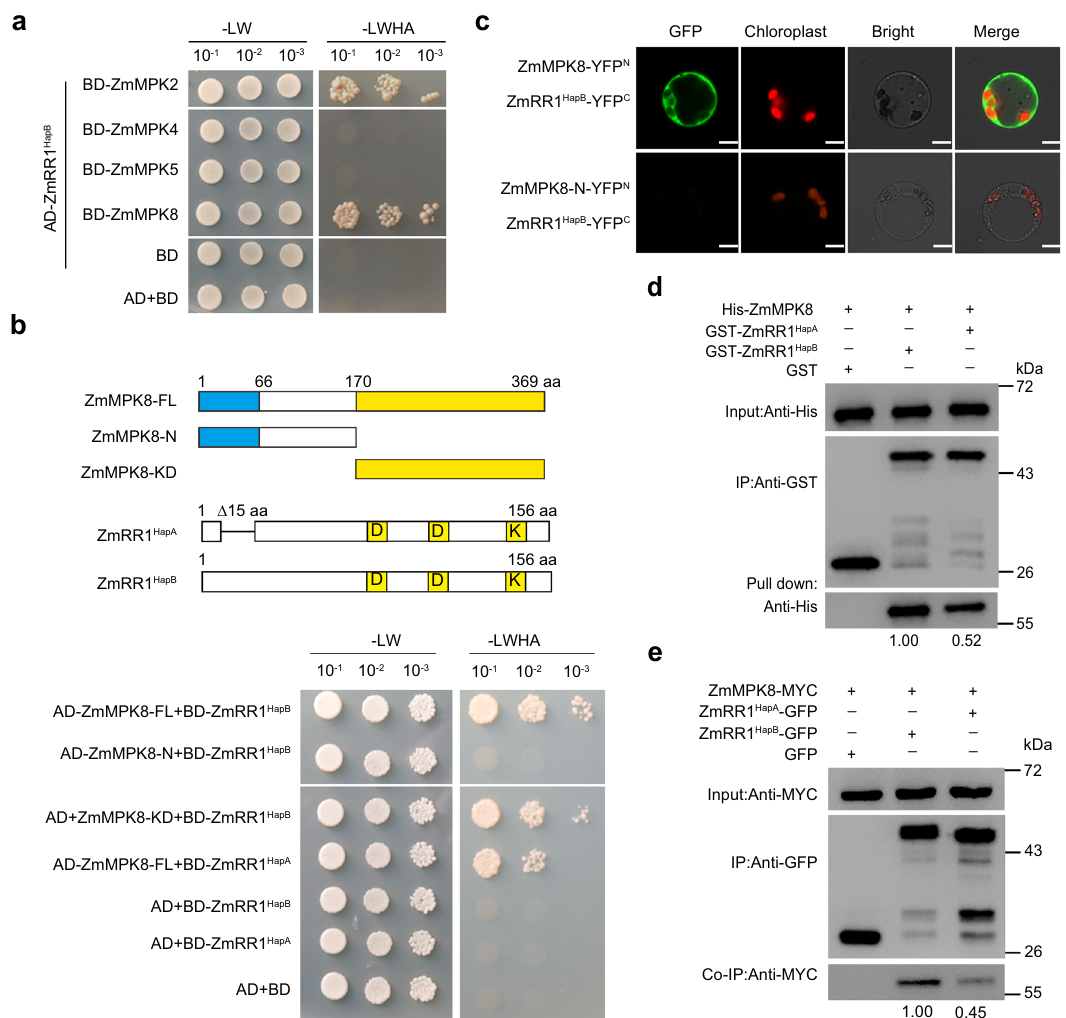
Fig. 2 ZmMPK8 interacts with ZmRR1 in vitro and in vivo. a Interactions of ZmMPKs with ZmRR1 in yeast. Yeast cells were grown on SD/-Leu/-Trp or SD/-Leu/-Trp/-His/-Ade medium. b The interaction of ZmMPK8 with ZmRR1 HapA and ZmRR1 HapB in yeast. Diagram of full-length and truncated ZmMPK8 constructs with speci fi c deletions and ZmRR1 HapA and ZmRR1 HapB constructs (top). c Bimolecular fl uorescence complementation assay (BiFC) showing the interaction between ZmMPK8 and ZmRR1 in maize protoplasts. Maize protoplasts co-expressing ZmMPK8-YFP N or ZmMPK8-N-YFP N with ZmRR1-YFP C were incubated in the dark for 15 h. The GFP signals were visualized by confocal microscopy. Bar = 5 μ m. d In vitro pull-down assay showing the interactions between ZmMPK8 and ZmRR1 HapA/B . e Co-IP showing the interactions between ZmMPK8 and ZmRR1 HapA/B . Total proteins from maize protoplasts co-expressing ZmMPK8-MYC with ZmRR1 HapA -GFP or ZmRR1 HapB -GFP were immunoprecipitated with GFP beads and detected with anti- MYC antibody. In a – e , a representative experiment from three independent experiments is shown. Source data underlying Fig. 2d and e are provided as a Source Data fi